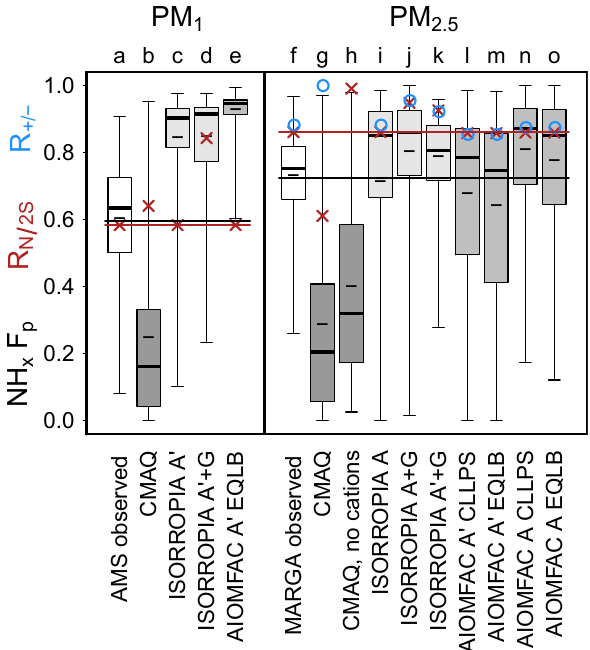
Figure 2. Gas–particle partitioning of ammonia (NH x F p = ammonium/(ammonia + ammonium)), mean R N / 2S (red × ), and mean R + / − (blue ◦ ) for PM 1 measured with the Georgia Tech AMS (Xu et al., 2015a) and PM 2 . 5 measured with a MARGA (Allen et al., 2015) as well as predicted by a CMAQ regional chemical transport model calculation and box models for SOAS conditions at CTR. F p box plots indicate the maximum, 75th percentile, median, 25th percentile, and minimum. Short dashes within the box plots indicate the mean F p . Box model inputs were either the aerosol (A) or aerosol and gas concentrations (A + G). Box models were run with either the ammonium–sulfate system (A (cid:48) ) or including all cations and anions (A). AIOMFAC calculations assumed complete liquid–liquid phase separation between the organic-rich and electrolyte-rich phases (CLLPS) or employed a full equilibrium calculation with organic compounds in which phase separation was calculated based on composition (EQLB). Observed gas-phase ammonia concentrations are from the SEARCH network at CTR. Box plots are labeled by a letter for easier reference in the text. Shading of the box plot interquartile range distinguishes different models (CMAQ, ISORROPIA, and AIOMFAC). The horizontal lines correspond to mean observed NH x F p (black) and R N / 2S (red). A simulation is consistent with observations if it reproduces both NH x F p and R N / 2S